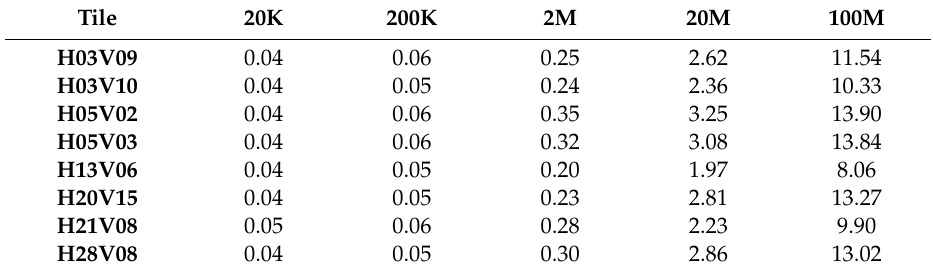
Figure 3. The pixel distribution of each class in comparative relation to the class upper limits (8000, 80,000, 800,000, 8,000,000, and 40,000,000, respectively) for a total of 20K, 200K, 2M, 20M, and 100M stratified training samples. Table 4. The time cost (hour) of generating a classification model for 20K, 200K, 2M, 20M, and 100M stratified training samples.